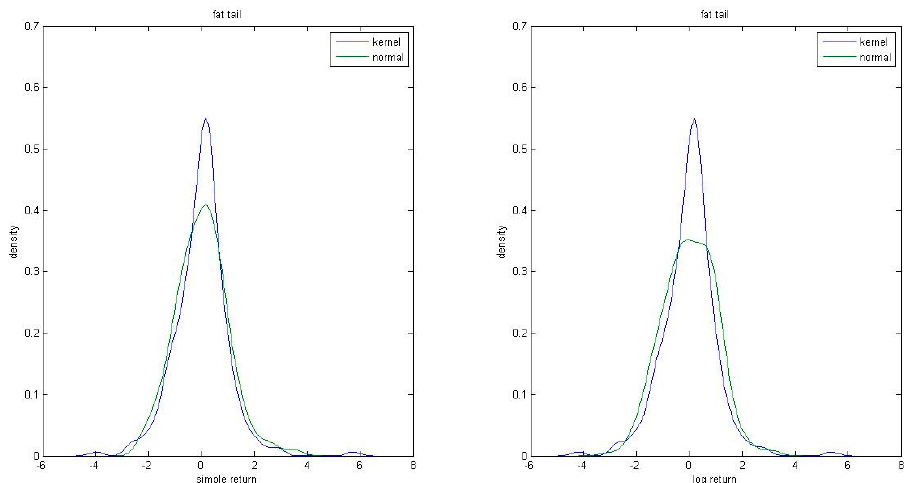
Figure 3. A comparison of simple return and log return of daily Yahoo finance densities (blue) with normal densities (green). The above figure compares the empirical Tableau densities with normal densities and shows that the Tableau data reveals obviously a fat tail and high peak.